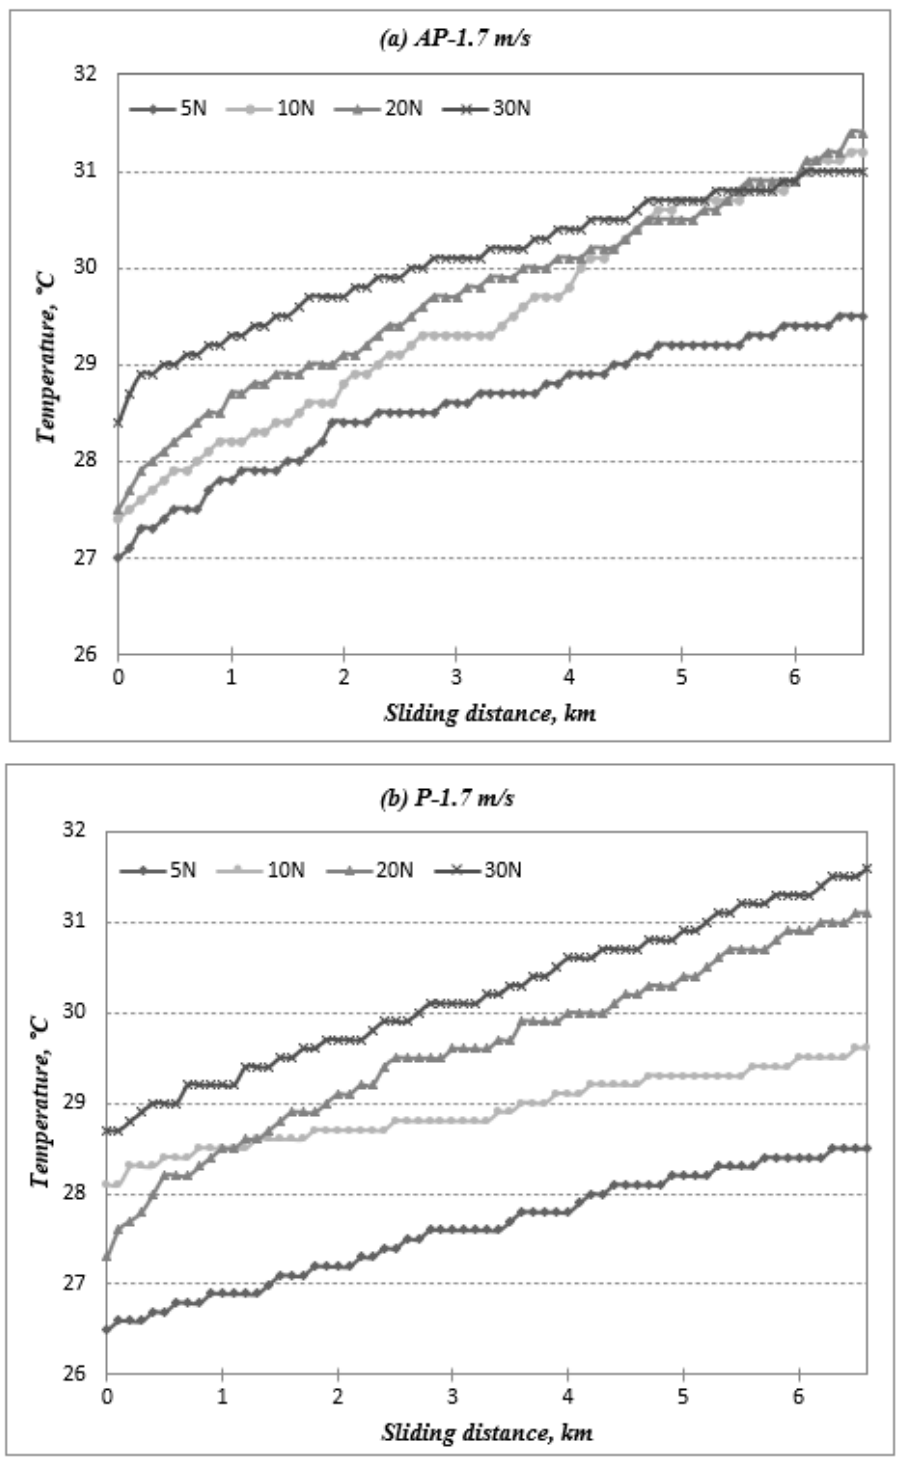
Figure A4. Temperature vs. sliding distance for AP and P fibre orientation subjected to different applied normal loads at 1.7 m/s counterface sliding velocity .